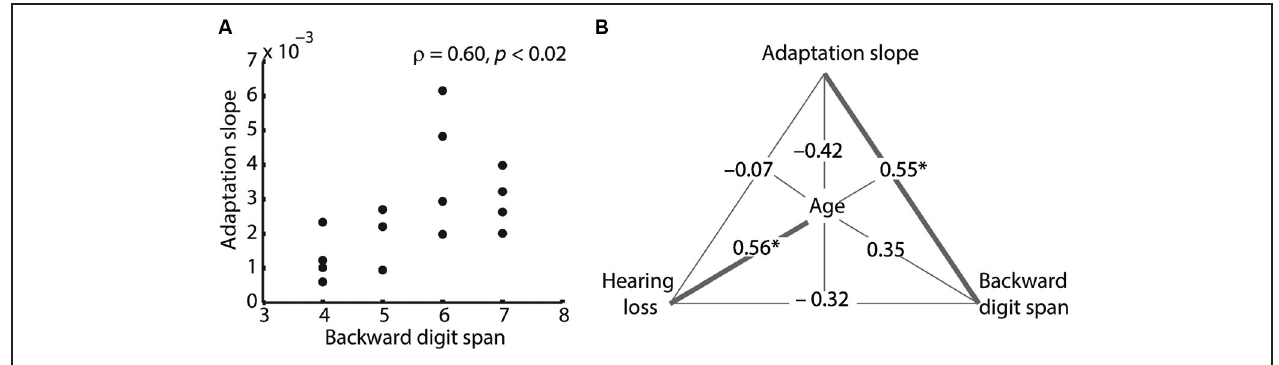
FIGURE 2 | Spearman’s correlations between behavioral measures. (A) Adaptation slope correlated positively with backward digit span. This correlation remained significant, when the outlier participant with a slope of 0.006 was removed ( ρ = 0.62, p = 0.18). (B) Partial correlations between adaptation slope, age, backward digit span and hearing loss (pure-tone average; PTA). Spearman’s correlation coefficients are shown.